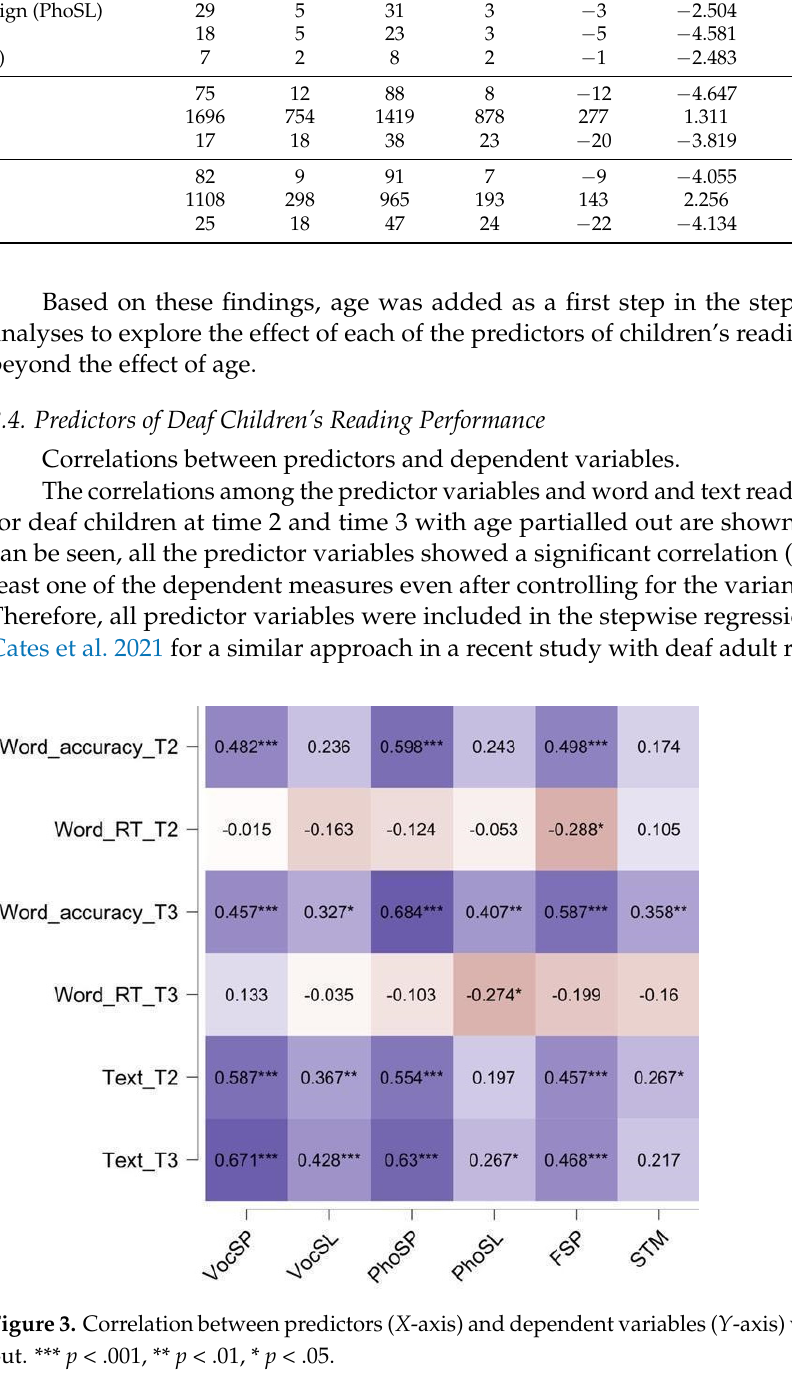
Table 3. Mean scores and statistical comparisons of year 3 (Y3) and year 5 (Y5) deaf children on predictor variables at time 1, and word and text reading fluency at time 2 (T2) and time 3 (T3) and results of the independent samples t -tests comparing both groups. At time 1 (T1), year 3 children were approximately 8 years and year 5 children were approximately 10 years of age. Significant predictors are bolded.